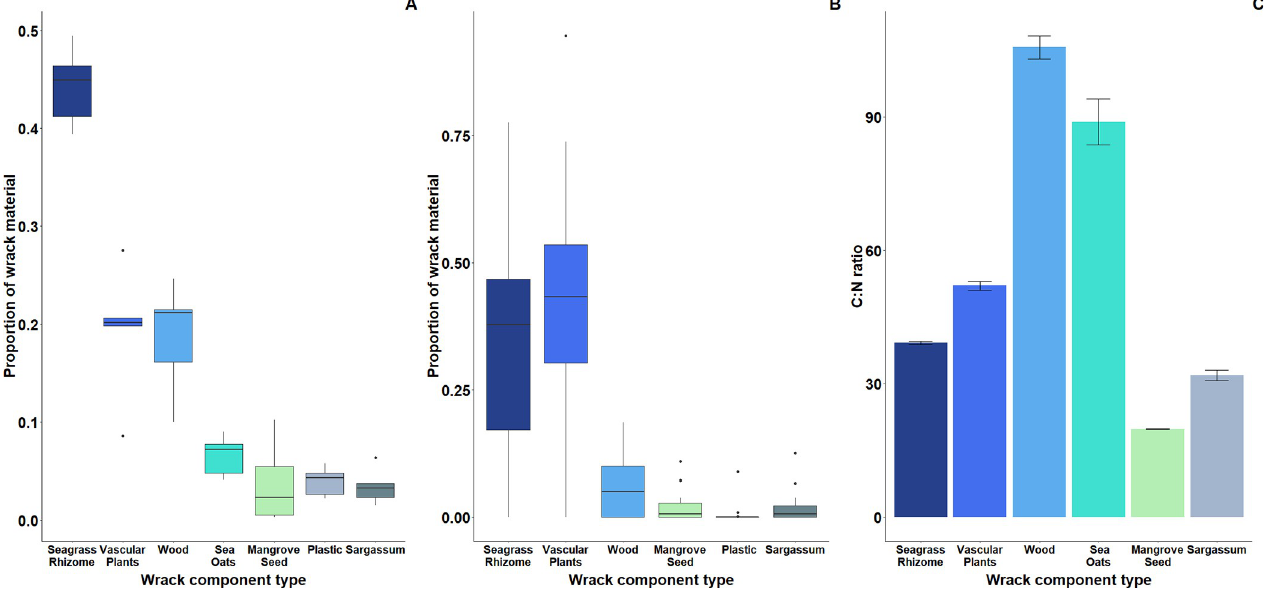
Fig 1. The composition of storm wrack in experimental plots and eastern Florida coastline. Proportions of different components of storm wrack A) collected from experimental removal plots (see S5 Fig for proportions in each block) and B) from surveys of wrack observed at 21 coastal dune sites along the north-east Florida coastline following hurricane Irma. C) Mean ( ± standard error; n = 15) C:N ratio of organic materials from experimental wrack removal plots.